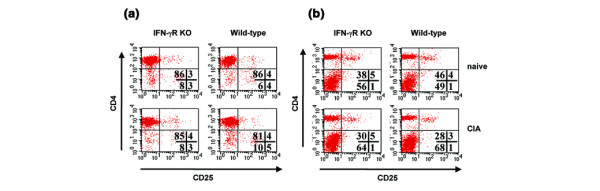
IFN-γ is not required to establish normal numbers of CD4+CD25+ Treg cells. Thymus cells (a) and lymph node cells (b) were isolated from IFN-γR KO and wild-type DBA/1 mice, either naive (upper row) or having been immunised 21 days previously with collagen type II in complete Freund's adjuvant (collagen-induced arthritis (CIA), lower row). Cells were stained with anti-CD25-FITC, phycoerythrin-conjugated anti-CD4 and propidium iodide. Dead cells were excluded by gating on propidium iodide-negative cells. The percentages of cells in each quadrant are indicated. Each plot represents a staining pattern of cells from a single female mouse. Identical profiles were observed in male mice. The staining pattern is representative of data obtained in three experiments (Table 1).